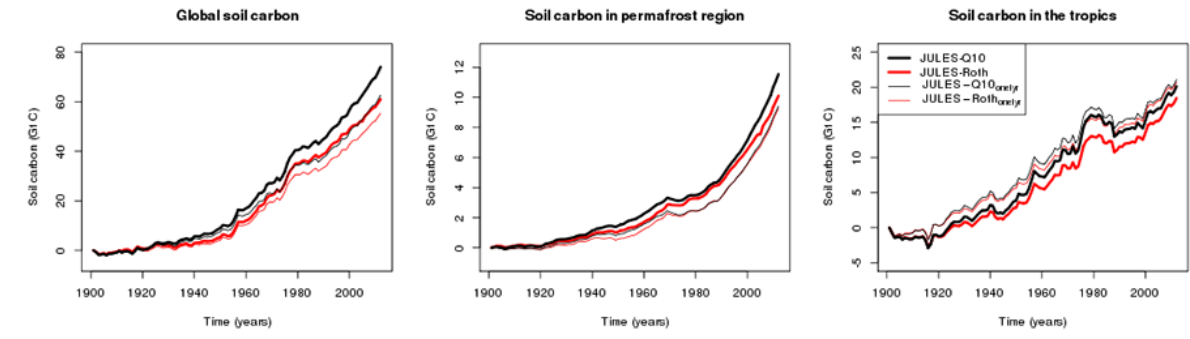
Figure 10. Time series of change in soil carbon (in PgC) over the 20th century for the three regions: global, permafrost and